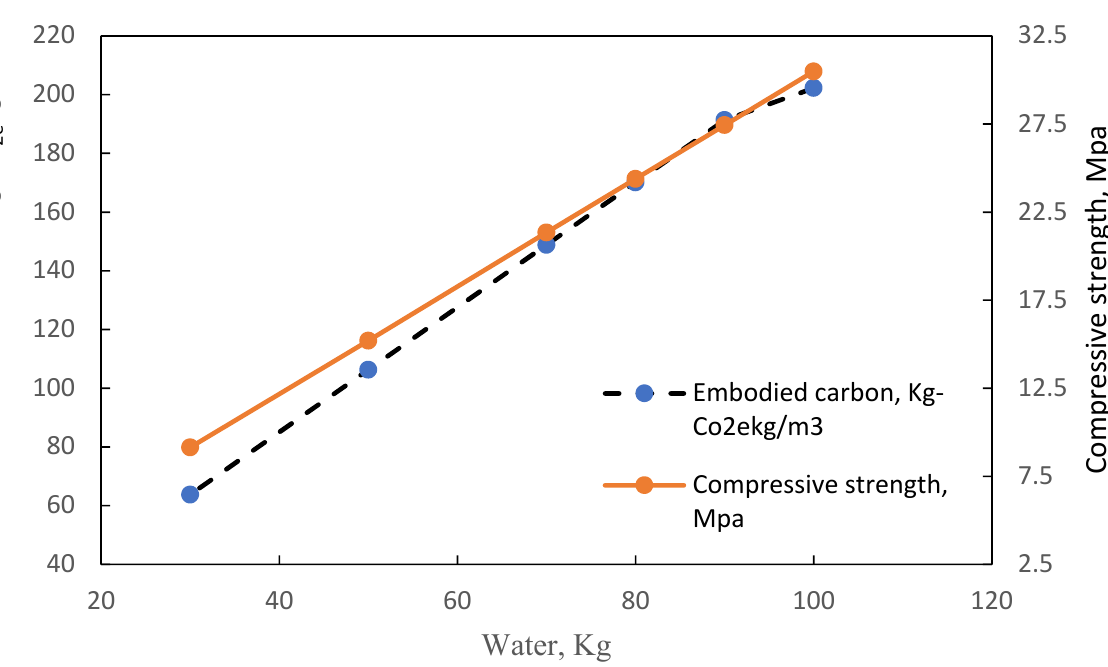
Figure 12. LCC at optimal water content of 130-150 litres per m 3 of concrete Batch A [32].